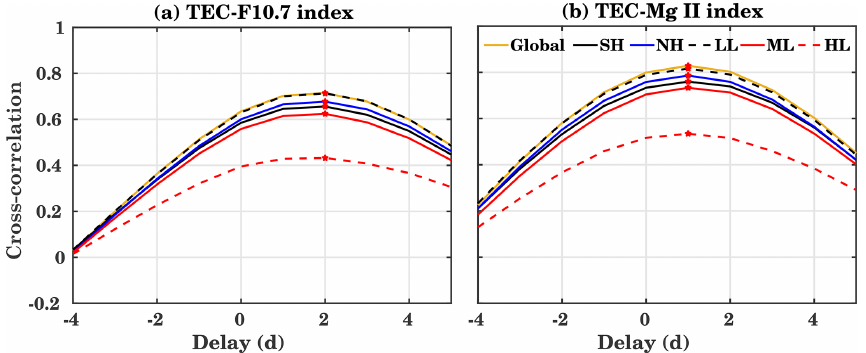
Figure 8. Cross-correlation coefficients and time delays between the global, Northern Hemisphere (NH), and Southern Hemisphere (SH) as well as low-latitude (LL, ± 30 ◦ ), midlatitude (ML, ± (30–60 ◦ )), and high-latitude (HL, ± (60–90 ◦ )) TEC with (a) F10.7 and (b) Mg II index during the years 1999 to 2017 for a different lag. A positive lag means that solar flux variations are heading TEC ones. The maximum correlation is indicated by a red